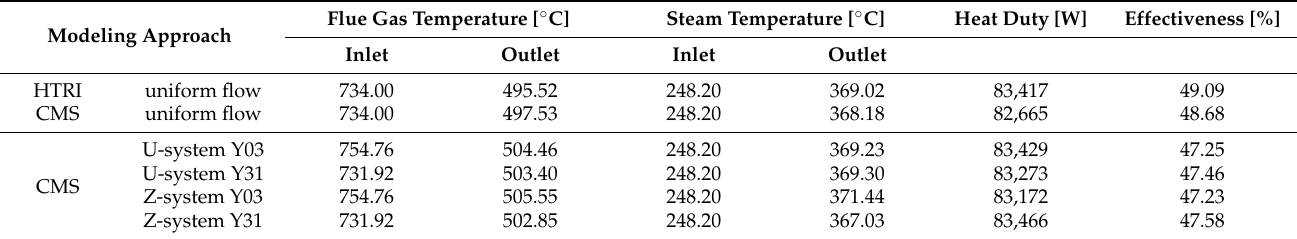
Table 8. Results of the thermal analysis of a single tube section in the